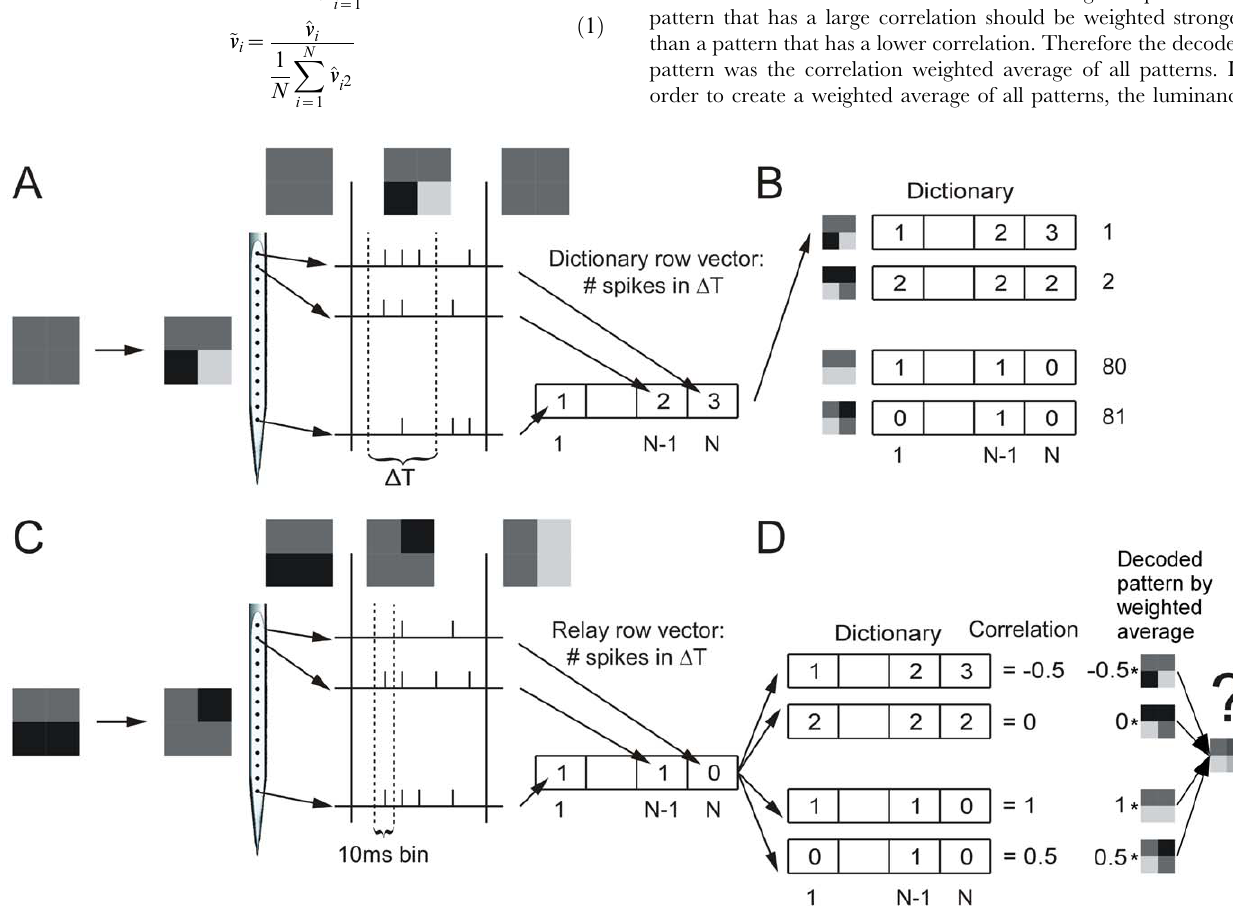
Figure 2. The decoding procedure. A: A pattern transition in the dictionary paradigm from a blank screen to a pattern. Multiunit activity was recorded with a single shank 16 leads electrode. The number of multiunit spikes was counted in a predefined time interval, D T, during the display of the pattern. In this study we used three different intervals, 0–250 ms, 0–90 ms and 90–250 ms. The number of multiunit spikes for each recording site was assigned to a vector (dictionary vector). This vector was associated to the presented stimulus pattern. B: Such a vector was then calculated for each of the 81 different patterns. C: A pattern transition in the relay paradigm (from one pattern to another pattern). The number of multiunit spikes was counted in 10 ms bins. The number of multiunit spikes for each recording site was assigned to a vector (relay vector). D: This relay vector was then correlated with each row vector in the dictionary. The resulting correlations were then used to weight the influence of the corresponding stimulus patterns. The weighted stimulus patterns were then averaged to create the decoded pattern.